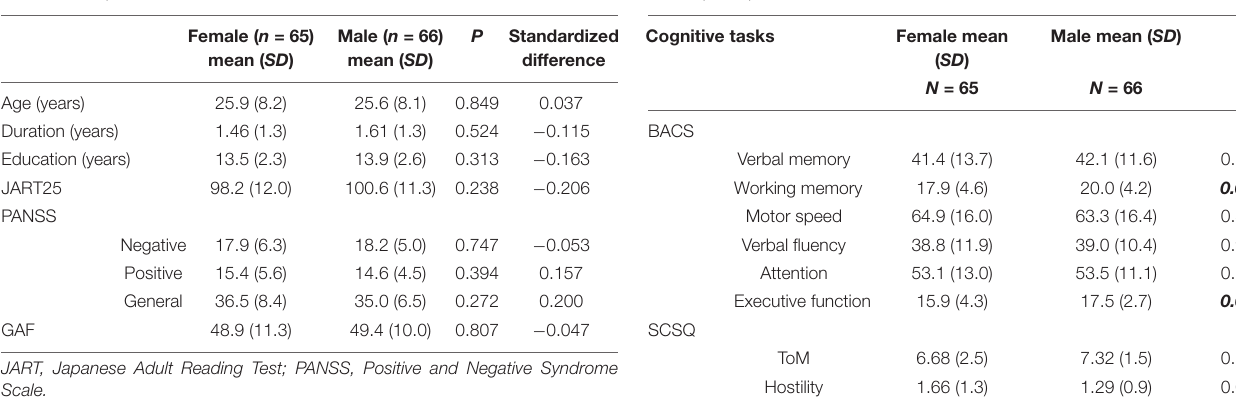
TABLE 1 | Sociodemographic variables and clinical data for participants with early course schizophrenia.